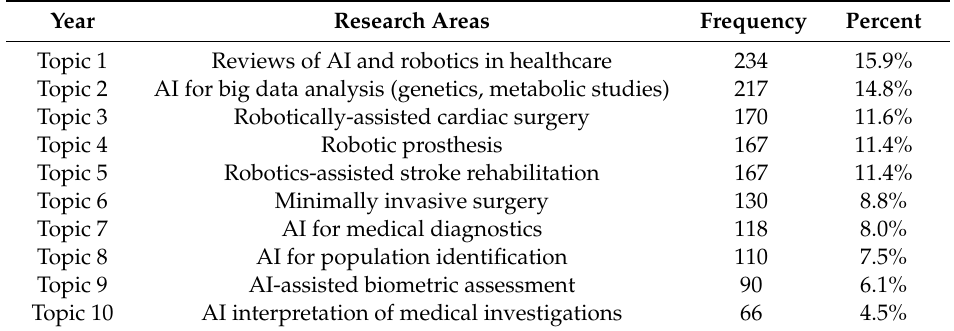
Table 5. Top 10 research topics classified by Latent Dirichlet allocation (LDA). AI = artificial intelligence.